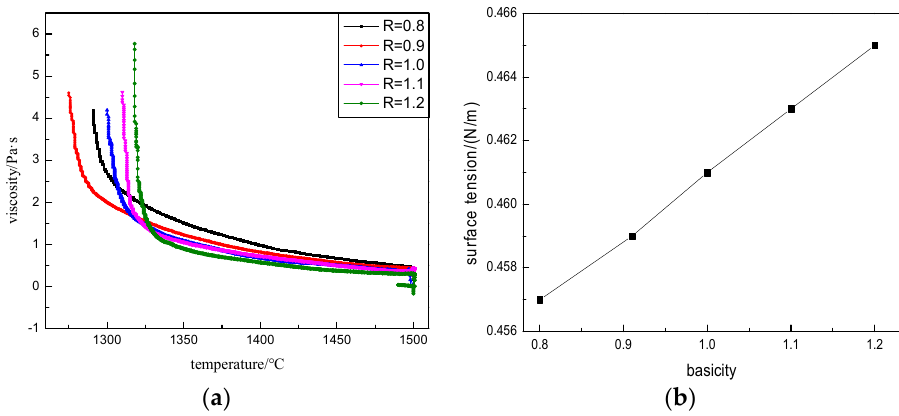
Figure 4. Visco-temperature curves and surface tension at different basicities. ( a ) Visco-temperature curves; ( b ) Surface tension at different basicities.